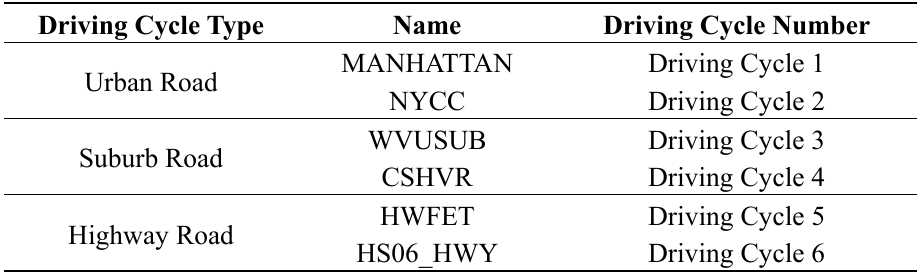
Table 1. Representative standard driving